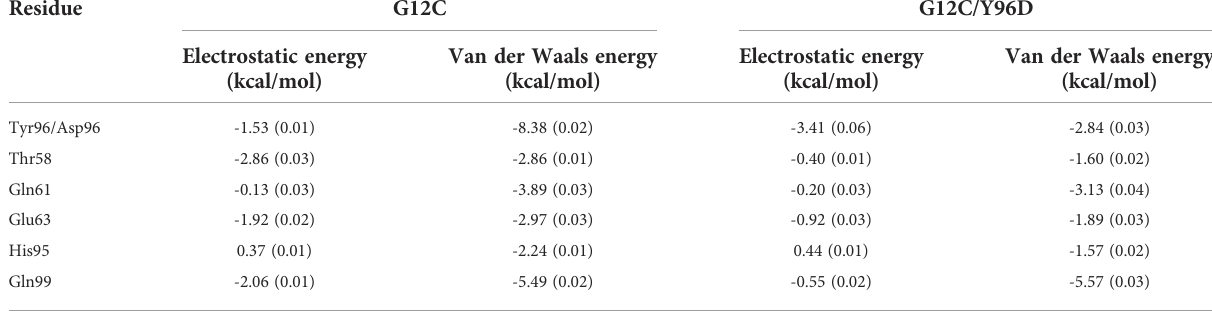
TABLE 1 Linear interaction energy (kcal/mol) between key residues and AMG510 in the two systems.